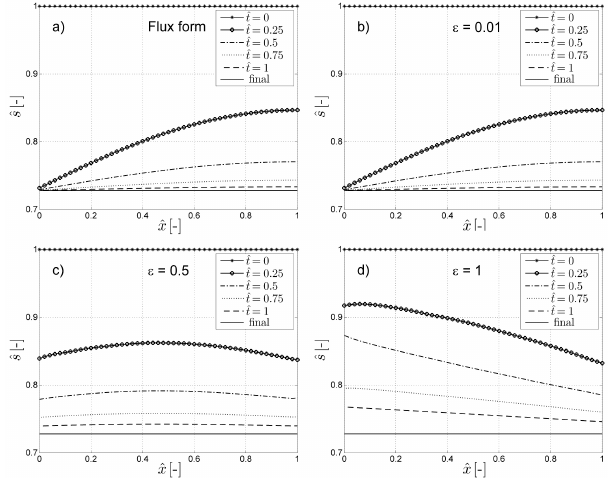
Figure 7. Slope profile evolution for the case ˆ E f = 1 / 2: (a) flux form; (b) entrainment form for ε = ¯ r / L d = 0 . 01; (c) entrainment form for ε = 0 . 5; and (d) entrainment form for ε = 1, using the thin- tailed exponential step length function of Eq. (8). The observed be- havior corresponds to that of Fig. 4. In the case of the flux form and the entrainment form with ε = 0 . 01, slope decrease is first re- alized upstream, and then propagates downstream in time. For the case ε = 0 . 5, slope more or less decreases simultaneously every- where, corresponding to the rotational evolution in Fig. 5c. In the case ε = 1, slope first decreases downstream, the e ff ect then gradu- ally propagating upstream in